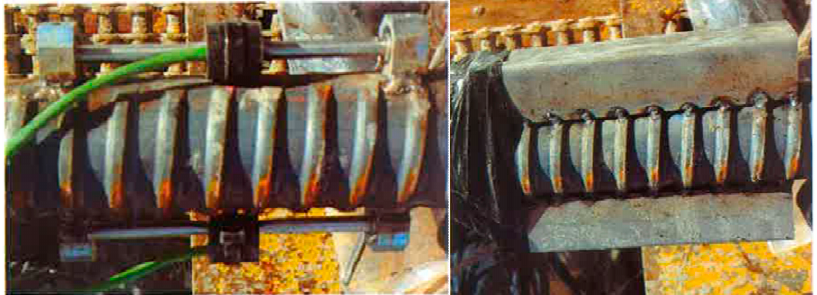
Figure 2. Picture of a pair of strain-gouges welded on the bar in mutually opposite position and detail of the cover plate adopted to protect the sensors.